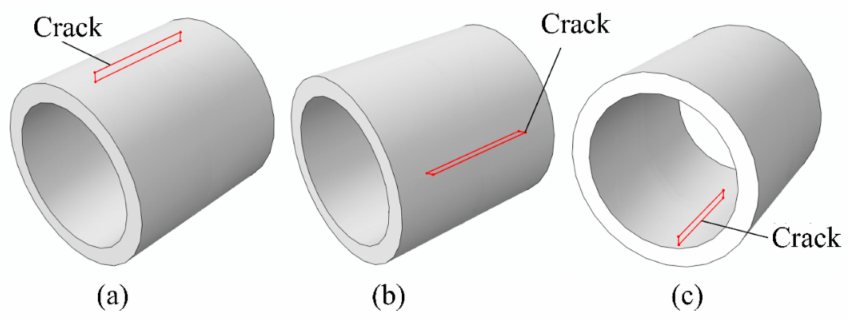
Figure 22. Pipes containing cracks at di ff erent positions: ( a ) crown, ( b ) springline, and ( c ) invert. (1) Load–strain